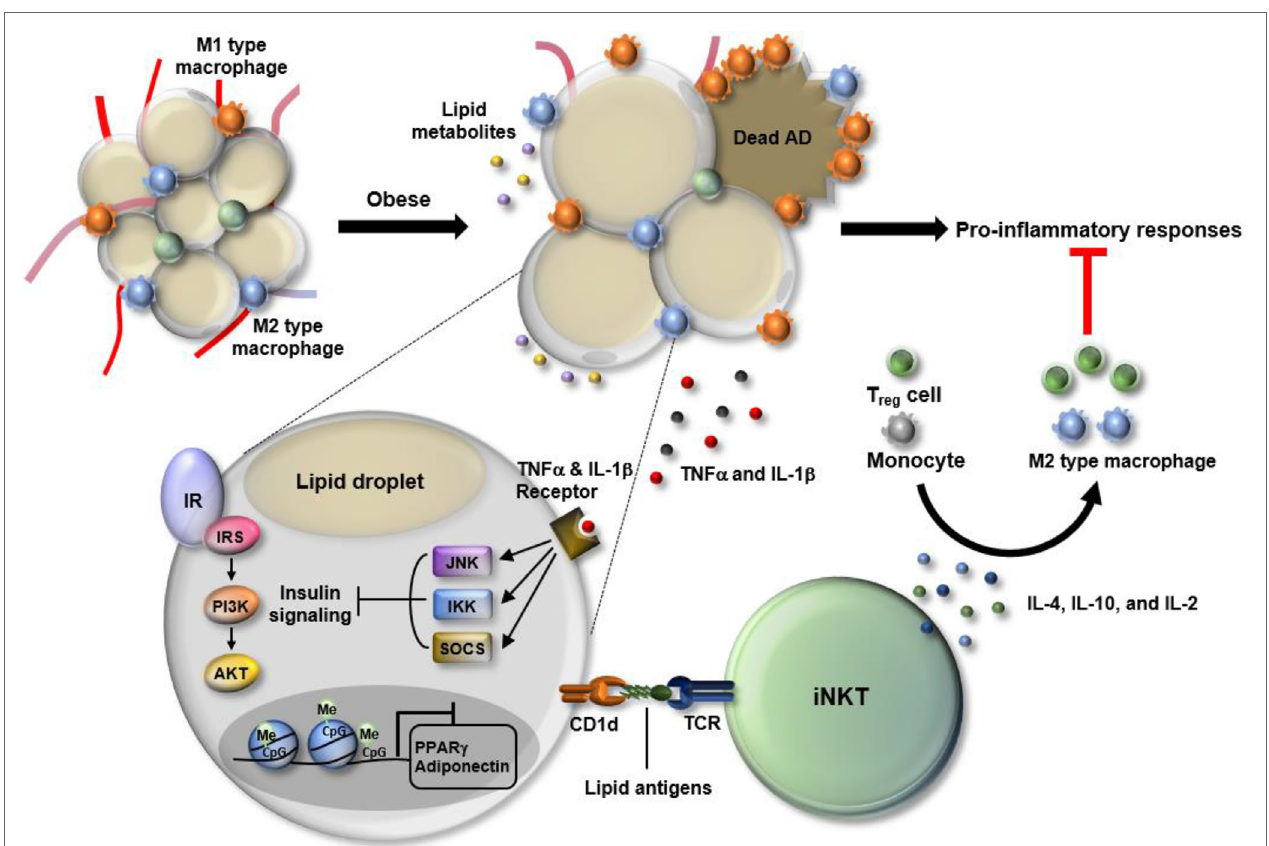
FigURe 1 | Dynamic changes in white adipose tissue (WAT) immunity in obesity. In the progression of obesity, WAT faces multiple stresses, including hypoxia, oxidative stress, and epigenetic malfunction. Particularly, adipocytes become enlarged in the process of absorbing excess nutrients, which is accompanied by adipocyte death and leakage of lipid metabolites. Also, obesity-induced DNA hypermethylation in adipocytes leads to the suppression of genes involved in adipocyte function including peroxisome proliferator-activated receptor gamma (PPAR γ ) and adiponectin. In response to such changes, WAT immunity skews toward pro-inflammatory state. Among cells residing in WAT, M1-type macrophages secrete a variety of cytokines, such as TNF- α and interleukin (IL)-1 β that activate JNK, IKK, and SOCS, leading to suppression of insulin signaling in WAT. Adipose invariant natural killer T (iNKT) cells have anti-inflammatory roles as a part of defense mechanism to resolve pro-inflammatory responses. Adipose iNKT cells are mainly activated by lipid antigens loaded onto adipocyte CD1d and secrete Th2-type cytokines, such as IL-4, IL10, and IL-2. Those cytokines drive the polarization of monocytes toward M2 type macrophages and activate regulatory T cells, contributing to an alleviation of the pro-inflammatory responses in